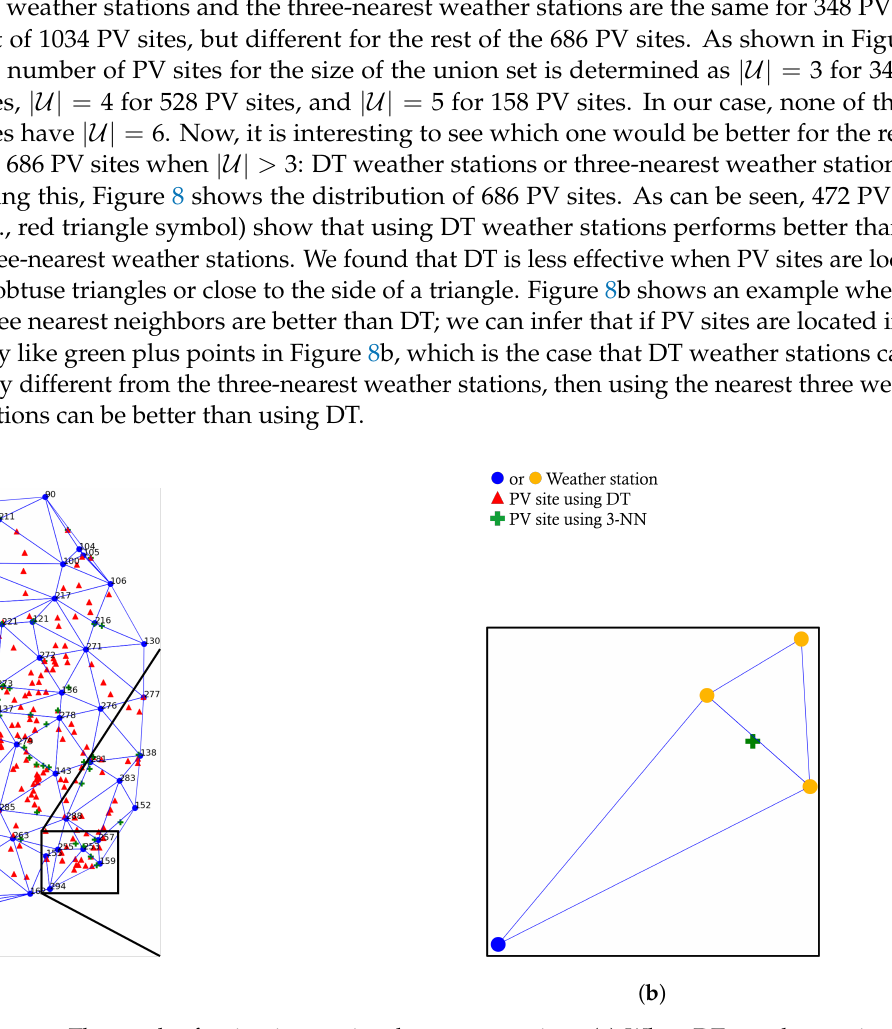
Figure 8. The result of union-inner triangles preprocessing. ( a ) When DT weather stations and 3-nearest weather stations are different, 66% of PV sites (red triangle) use DT weather stations and 34% of PV sites (green cross) use the 3 nearest weather stations. ( b ) An example when DT is not a good